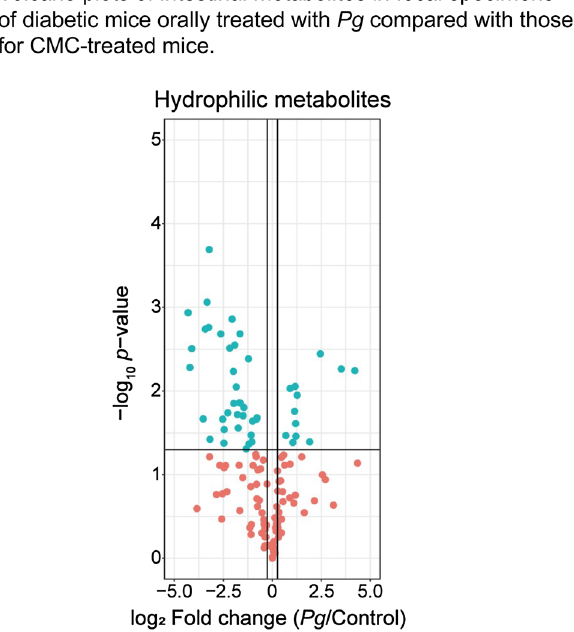
Figure 3. Volcano plot of fold change in the levels of intestinal hydrophilic metabolites in fecal specimens of db / db diabetic mice orally treated with Porphyromonas gingivalis ( Pg ) or CMC (control). Blue points represent a significant increase or